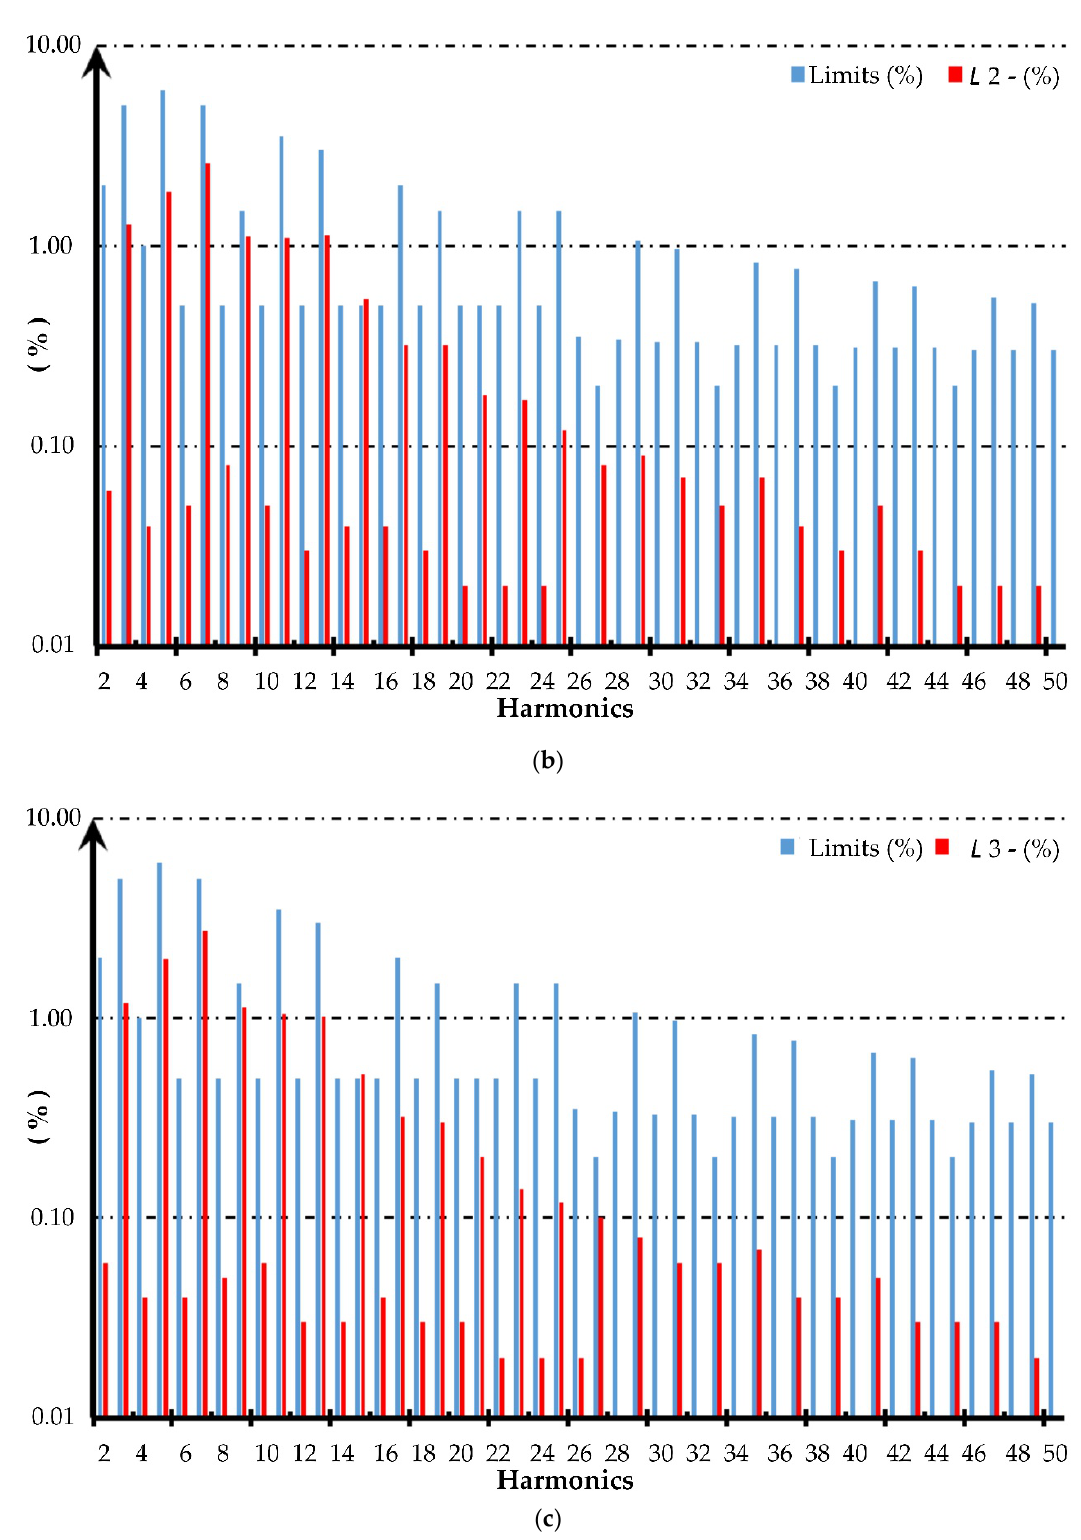
Figure 4. Harmonics in the supply voltage: ( a ) phase L 1; ( b ) phase L 2; ( c ) phase L 3. Figure 5 shows the changes in the RMS voltage during the measurements.